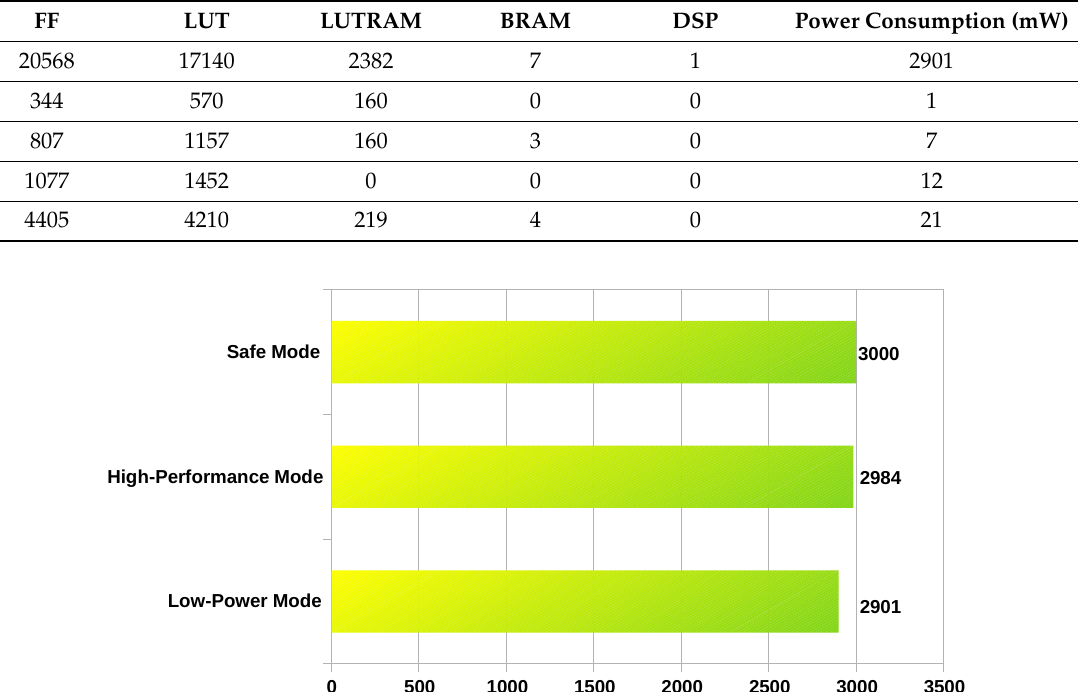
Table 1. Resources occupation and estimated power consumption.